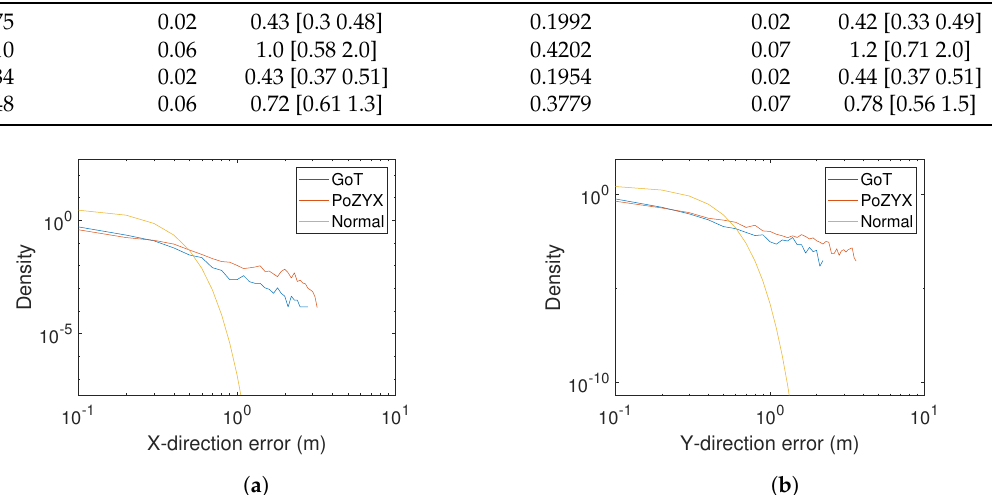
Figure 19. Log–log plots of absolute error for Pozyx and GoT, with scaled normal for comparison. ( a ) X-direction. ( b )